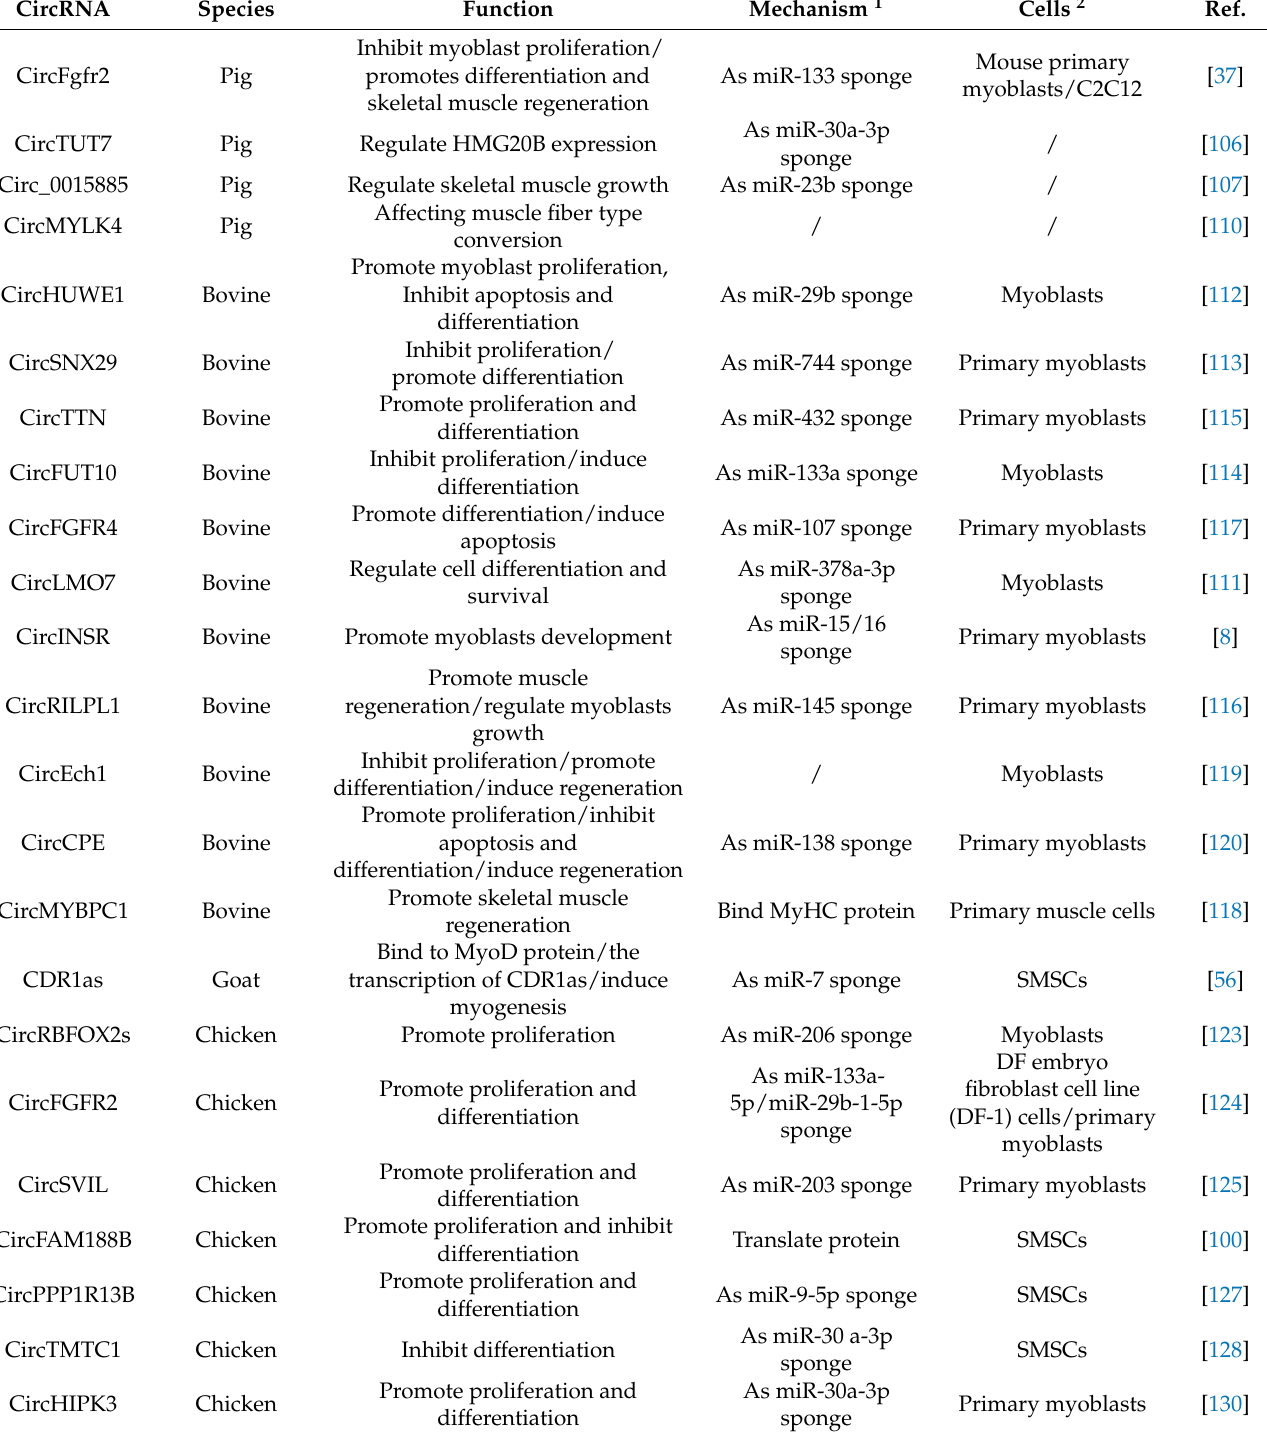
Table 1. Summary of circRNAs and their functions in skeletal muscle